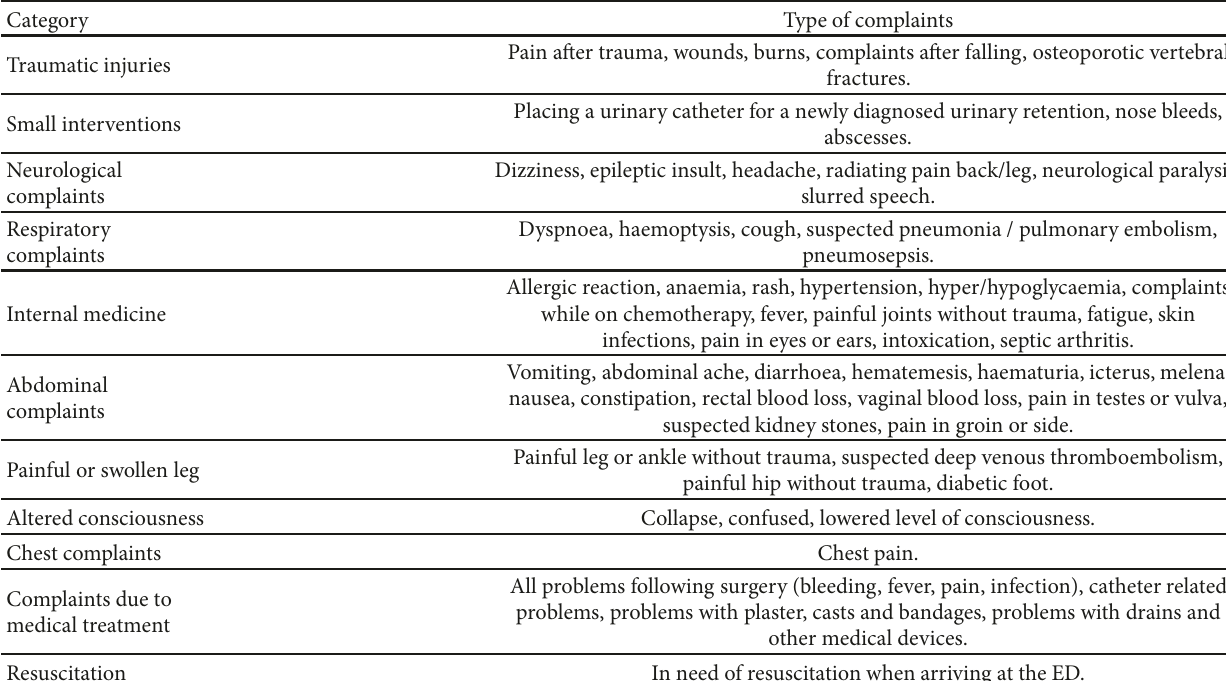
Table 1: Categories for presenting